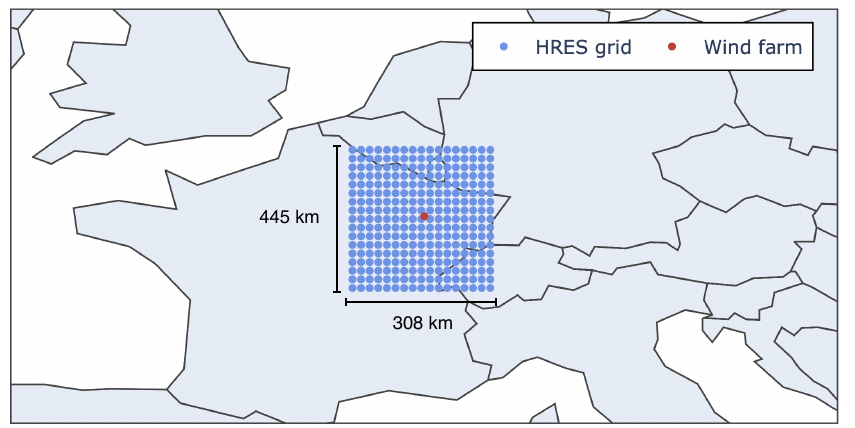
Figure 2. Map centered around the “La Haute Borne” wind farm in France. The blue dots represent the HRES 17 × 17 grid, while the red dot refers to the location of the wind